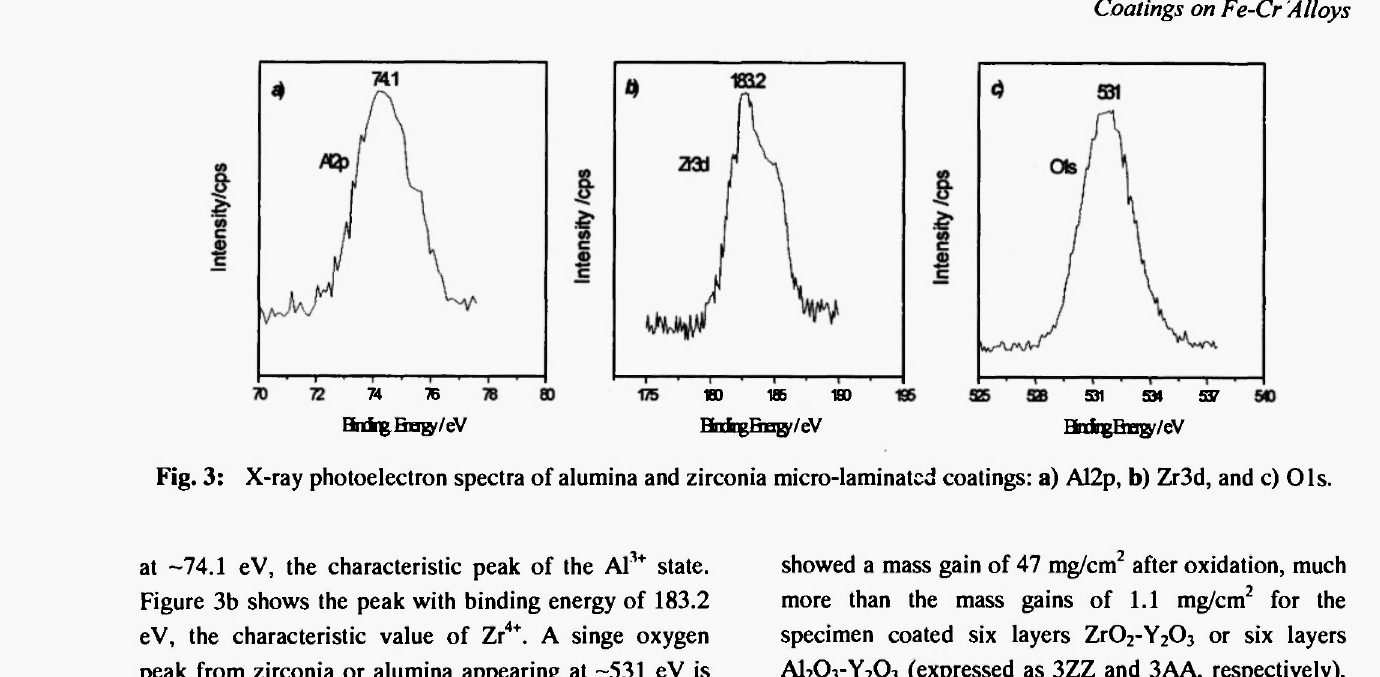
at ~74.1 eV, the characteristic peak of the Al 1+ state.